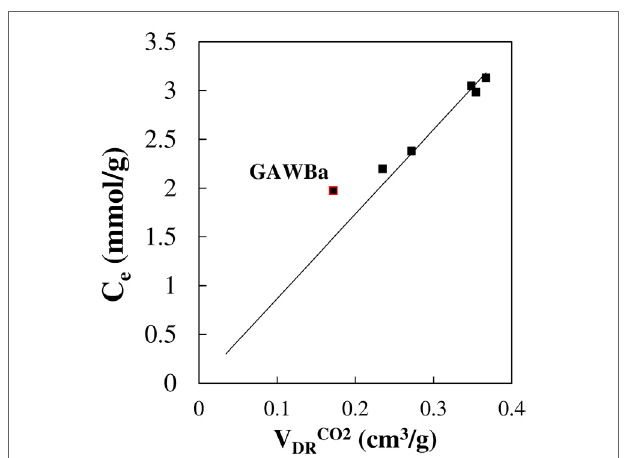
FigUre 6 | relationship between the experimental adsorption